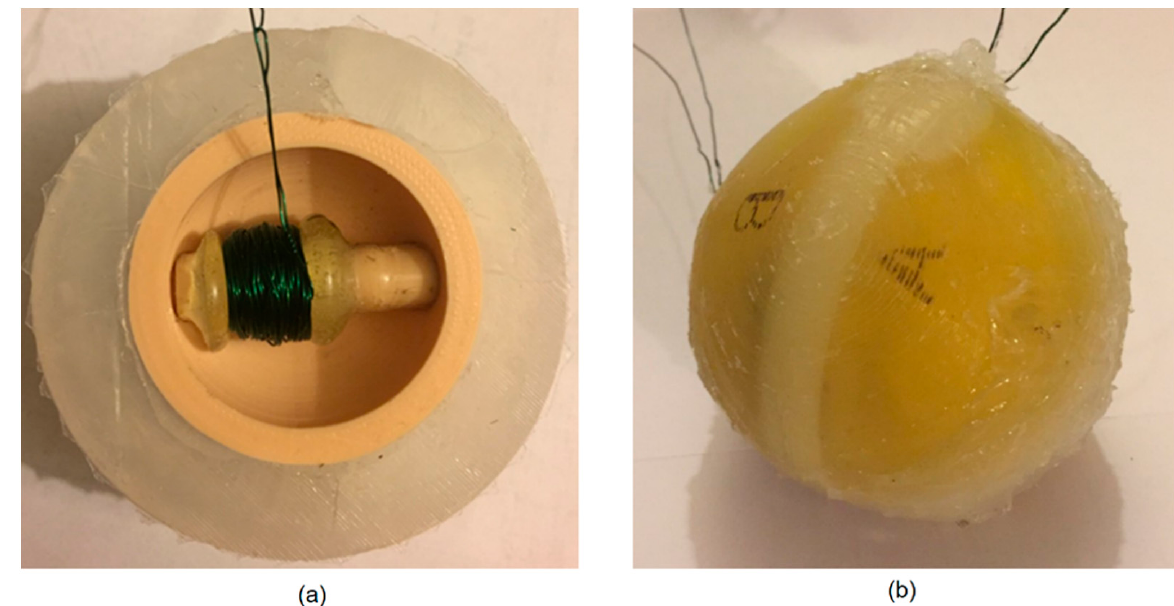
Figure 4. ( a ) Dissection of energy harvester body including the outer silicone shell, the rigid spherical core, coil, ball magnet, and tube. ( b ) Fabricated ball-shaped energy harvester. The two wires are for each coil in the core. The outer surface is divided to four sides and marked as A, B, C, and D for testing purposes.